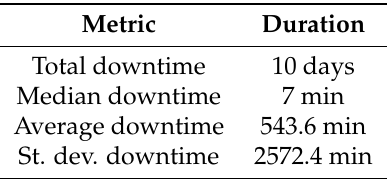
Table 2. Statistics of the 24 the outage events, collected using UptimeRobot.com